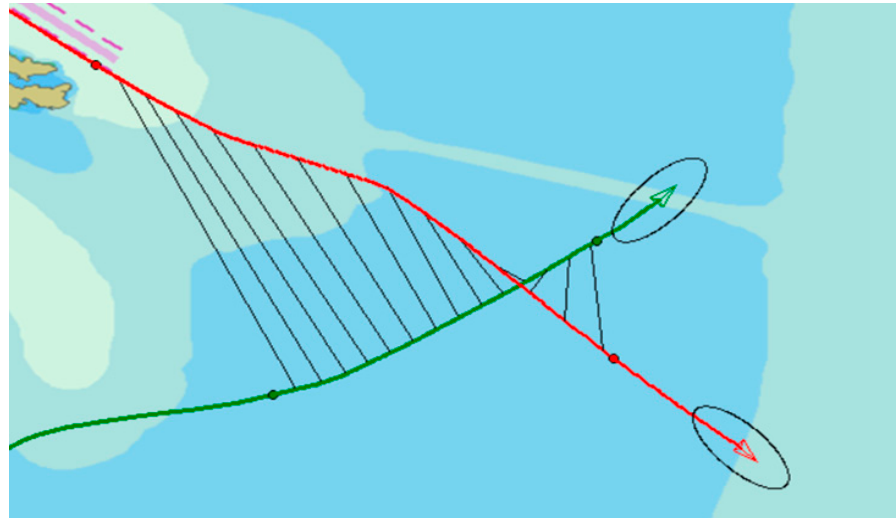
Figure 12. Ship encounter AIS trajectory data.